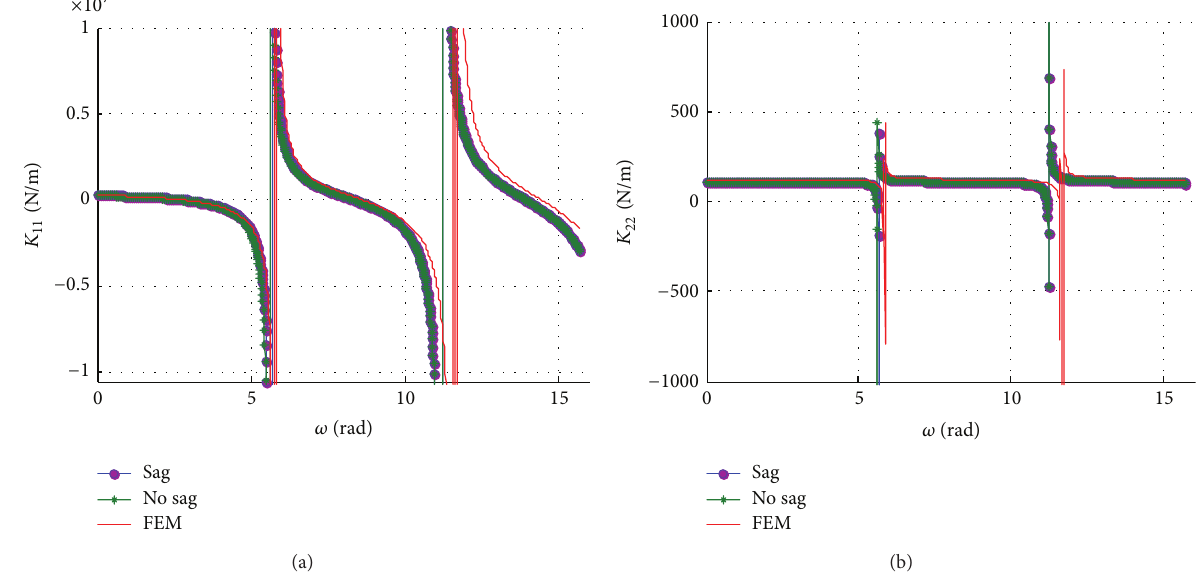
Figure 7: Variation curve for the frequency domain of the dynamic stiffness at the midpoint of a cable ( 𝜇 1 = 0.5 ).